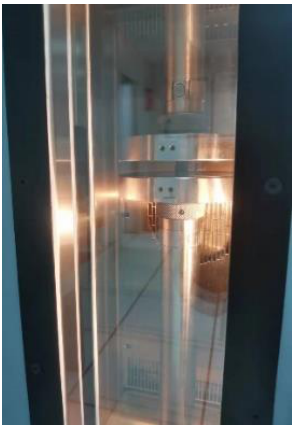
Figure 4. Environmental chamber.